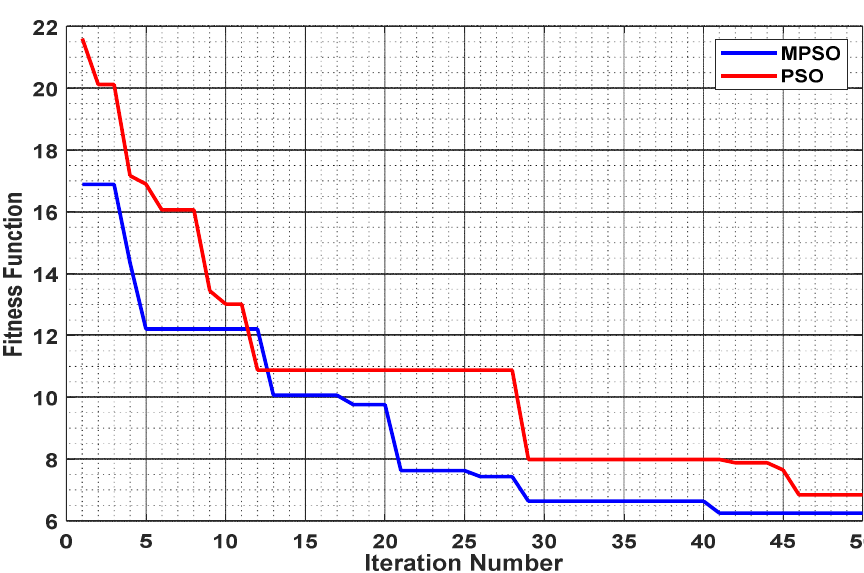
Figure 9. Convergence Curve for PSO and